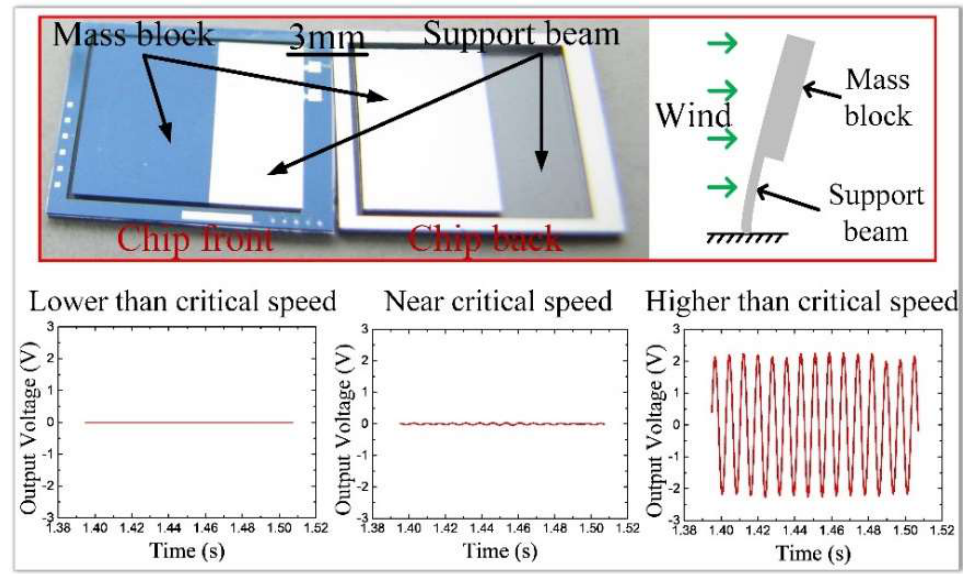
Figure 1. The microcantilever anemometer fabricated by our group, and the effect of wind-induced vibration on the output response of the anemometer under different wind speeds.